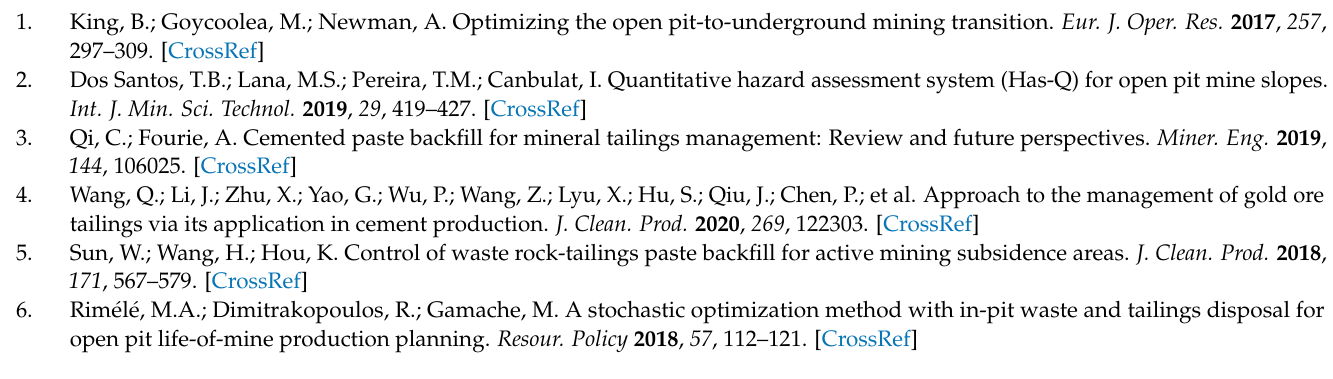
S2: Uniform design ratios; Table S3: Results of uniform parameter tests; Table S4: Simulation results of safety factors of roofs and underground backfill